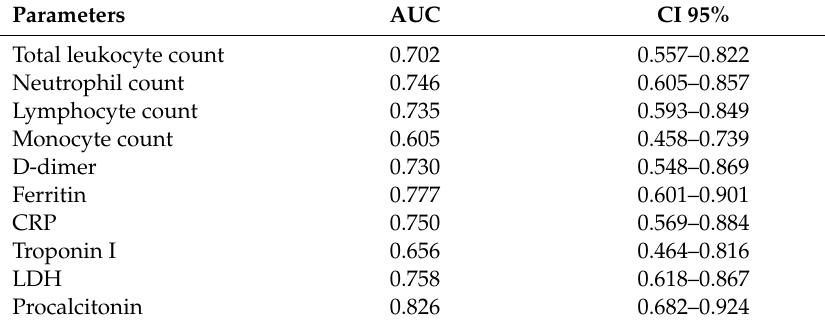
Table 5. Area under the ROC curves for hematological, biochemical, and immune parameters to predict in-hospital mortality at admission in patients with severe Covid-19. Statistical analyses were performed by means of the MDCalc Software (New York, NY 10003, USA) and the IBM SPSS Statistics version 26.0 (IBM, Armonk, NY, USA). Di ff erences were considered significant when p < 0.05. Abbreviations: CRP, C-reactive protein; LDH, lactate dehydrogenase; ROC, Receiver Operating Characteristic curves; AUC, area under the ROC curve; CI, confidence